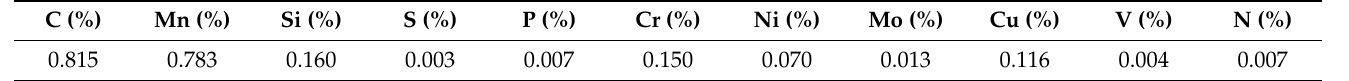
Table 1. Chemical composition (% weight) of the steel rods used in this